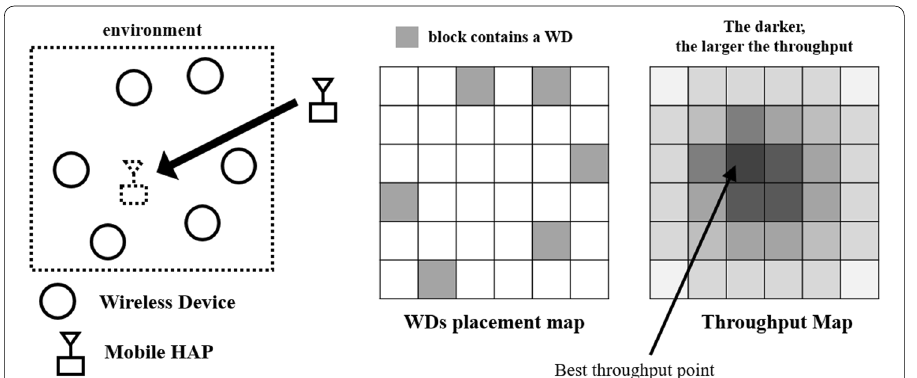
Fig. 1 The system architecture of our model. Wireless devices are placed in the environment, and we can represent the location of WDs as a WDs placement map. A mobile HAP is placed in the environment, and the throughput value of the environment is calculated and represented as a throughput